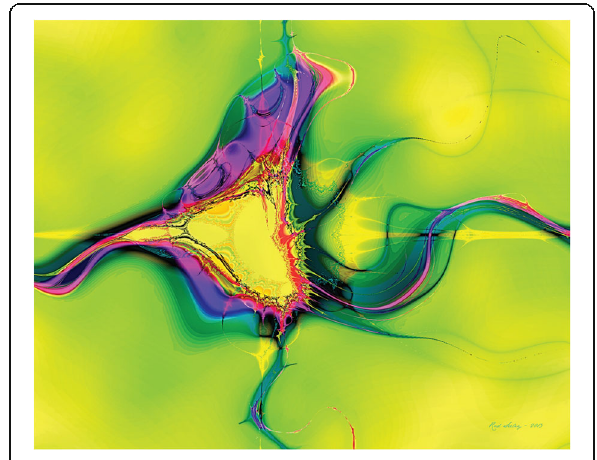
“ composition VIII ” (1923), “ black circles ” (1924), “ Yellow Red Blue ” (1925), “ several circles ” (1926), “ Hard But Soft ” (1927) and “ thirteen rectangles ” (1930).